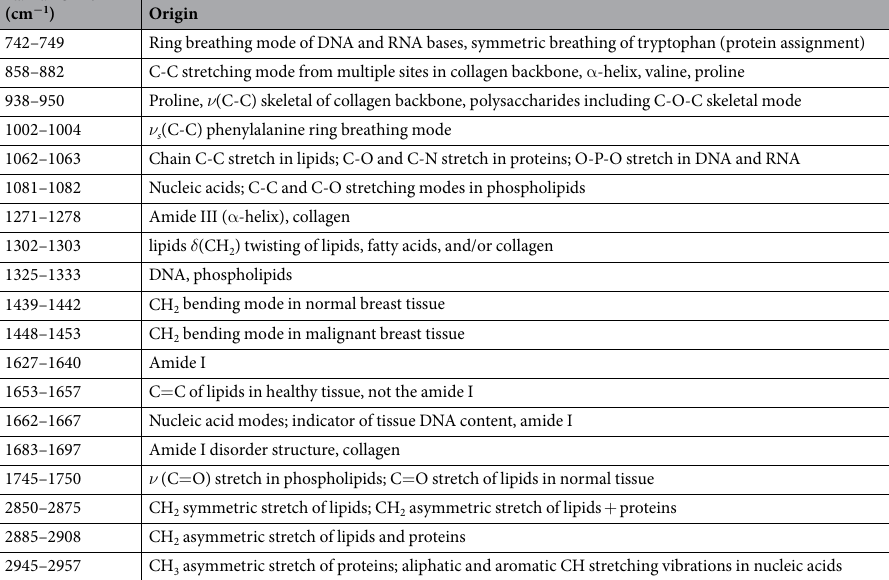
Table 1. Most likely Raman band assignments of interest in this study for breast cancer diagnostics 65,69–78 . Note: Peak assignments are given as a range covering the mean values generated by the two Raman